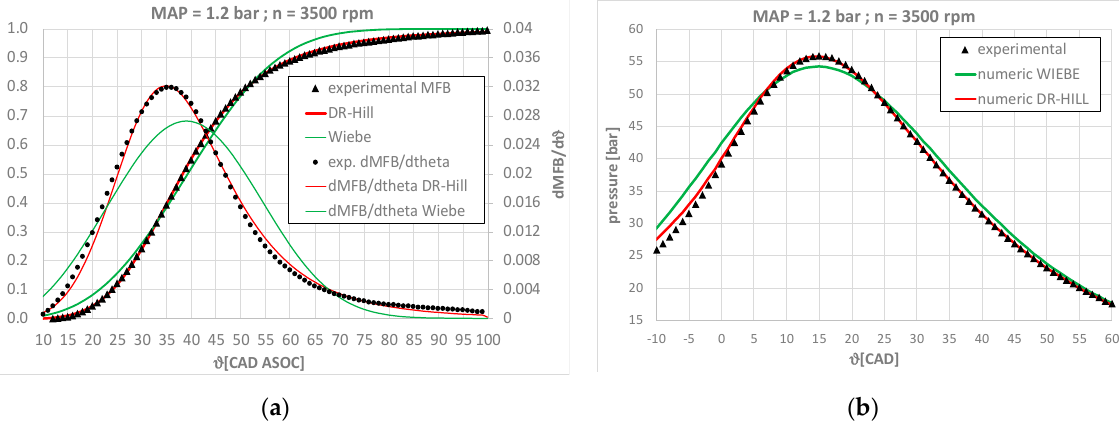
Figure 1. 100% NG; MAP = 1.2 bar; n = 3500 rpm. ( a ) Experimental MFB profile and its derivative interpolated with the best matching Wiebe and Hill functions; ( b ) Experimental and numeric pressure curves, simulated with the best matching Wiebe and Hill functions